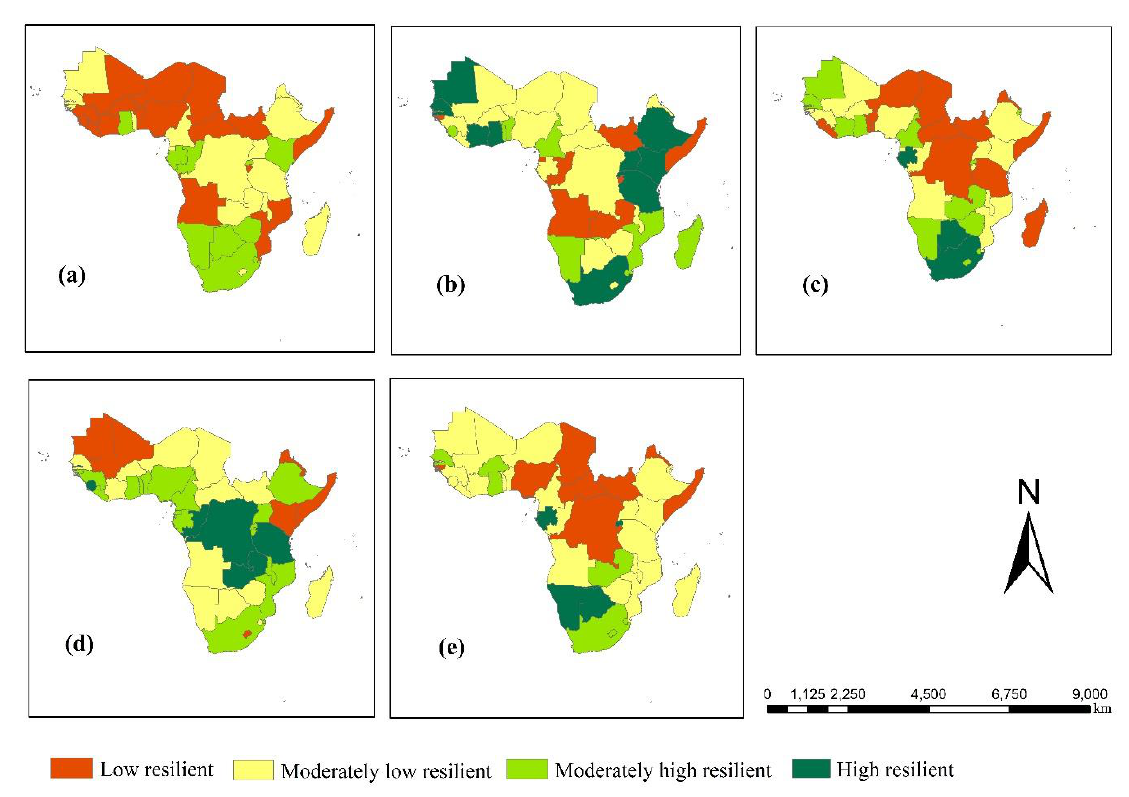
Figure 4. Resilience scores for five-dimension categories of SSA: ( a ) social, ( b ) economic, ( c ) infrastructure, ( d ) environment and ( e ) institution. Result classified into low, moderately low, moderately high, and high resilient. Table 3. The rank of countries in Sub-Saharan Africa (SSA) with five highest and lowest resilience scores. Overall